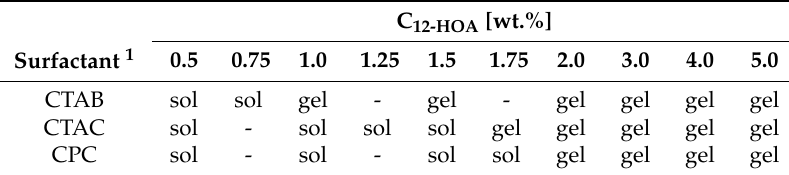
Table 1. Gelation test in the water / surfactant / 12-hydroxyoctadecanoic acid (12-HOA) systems. C 12-HOA [wt.%]